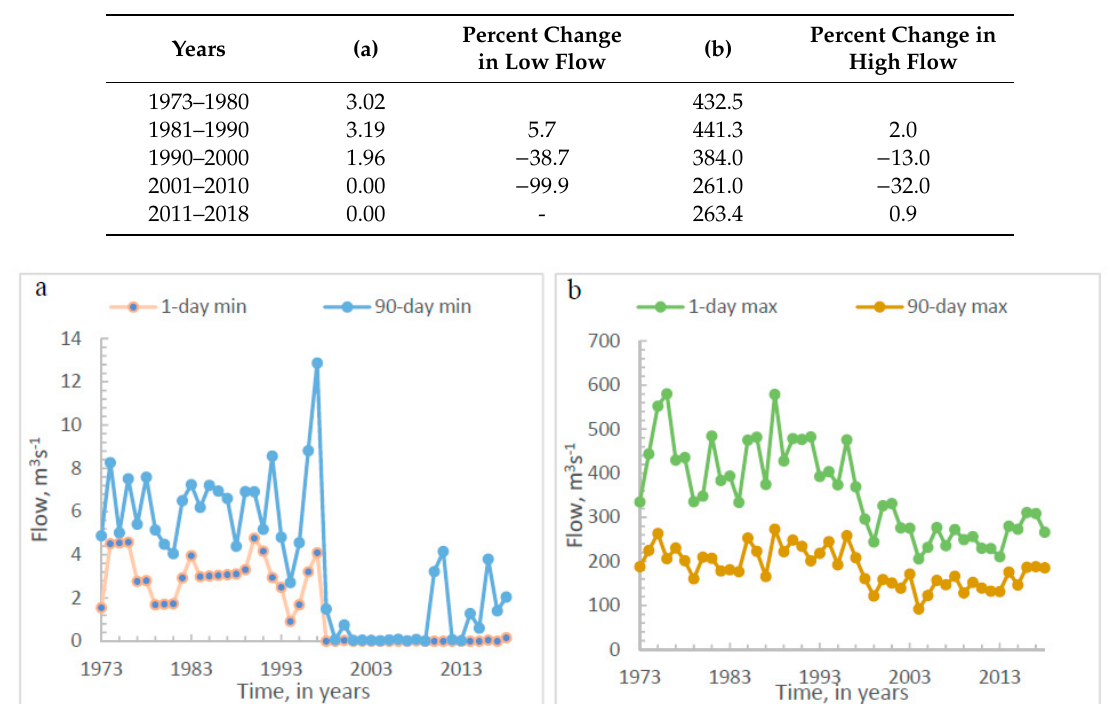
Figure 8. One-day and 90-day low ( a ) and high flow ( b ) of Gumara River at the outlet (1973–2018). The figure depicts ( a ) the lowest flow from each individual day of the year as 1-day duration low flow and the lowest flow of average 90 days as 90-day (seasonal) duration low flow and ( b ) highest flow from each individual day of the year as 1-day duration high flow; and highest flow of average 90 days as 90-day duration high flow.